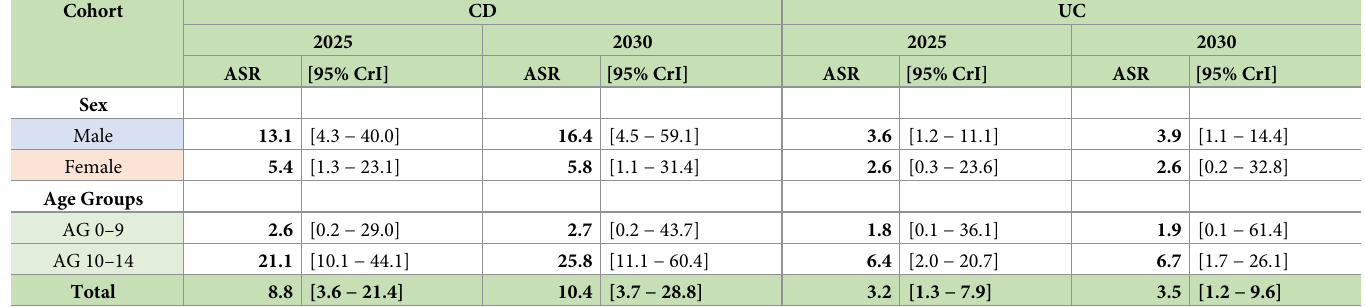
Table 4. Projected age-standardized incidence rates (ASR) (sex and age specific) of Crohn’s disease (CD) und ulcerative colitis (UC) per 100,000 person-years (PY) in Saxony for the years 2025 and 2030. Cohort CD